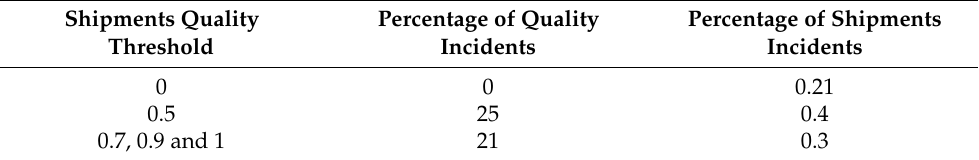
Table 7. Quality and shipments incidents results according to the quality threshold.